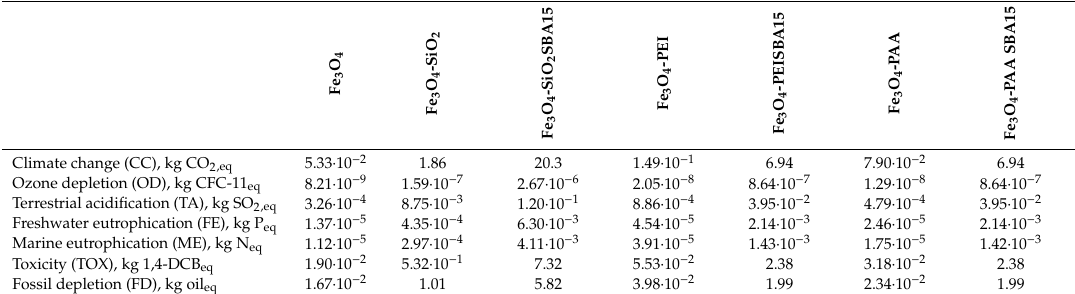
Table 1. Life Cycle Impact Assessment results for di ff erent types of Fenton catalysts.